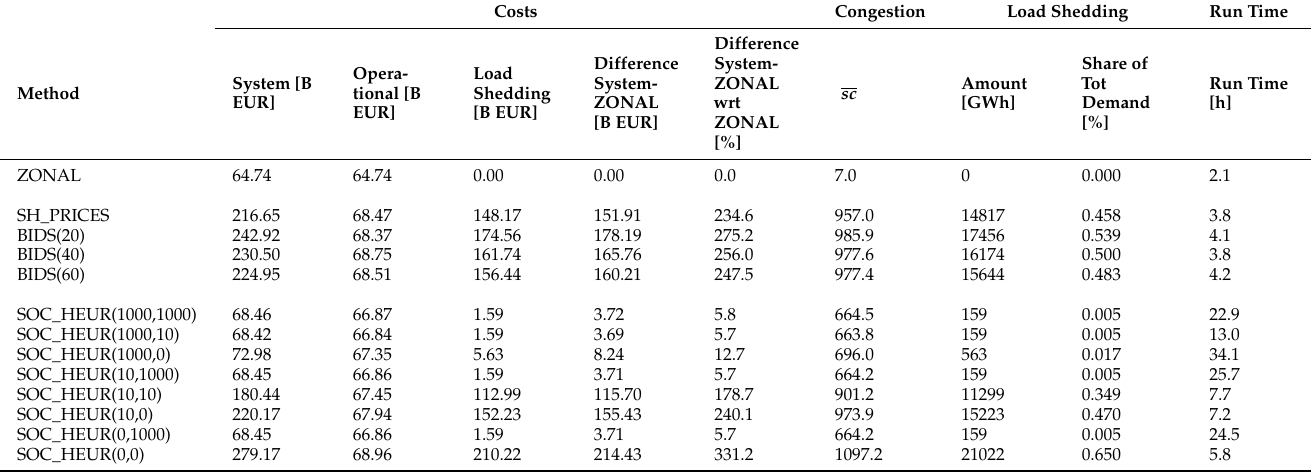
Table 3. Results overview for the long-time horizon benchmark with transmission capacity factor β = 0.7. Reported are for the different methods: the total system costs, which are made up of operational costs (i.e., power generation costs) and load shedding costs, the difference between ZONAL and the respective method in absolute amount and relative to the total system costs of ZONAL ; the average system congestion ( sc ); the total amount of load shed and the share of this amount with respect to the total load; and the run